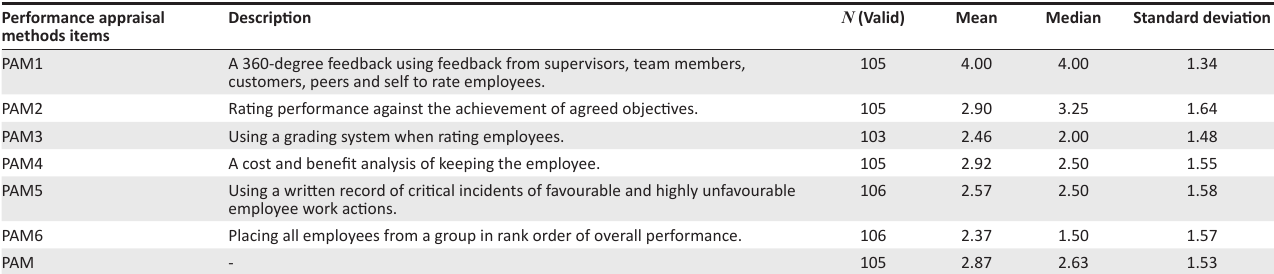
TABLE 2: Performance appraisal